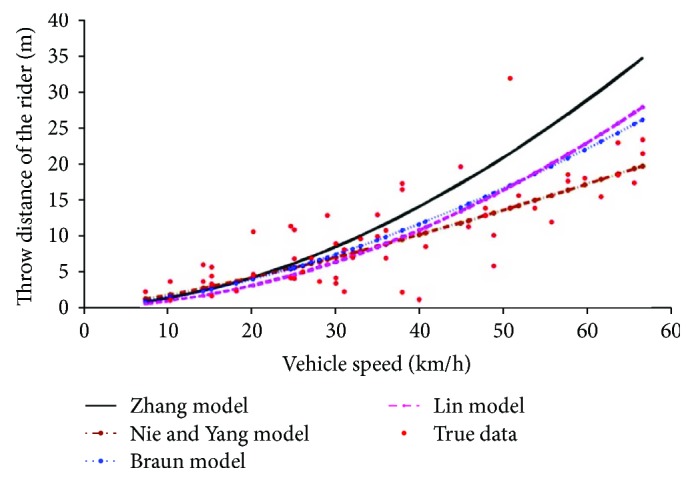
Data verification.